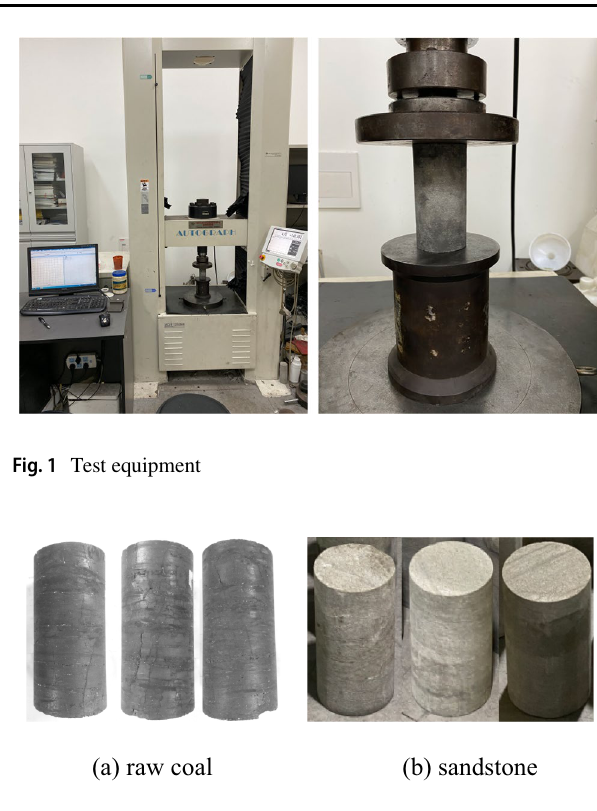
Fig. 2 Standard samples of raw coal and